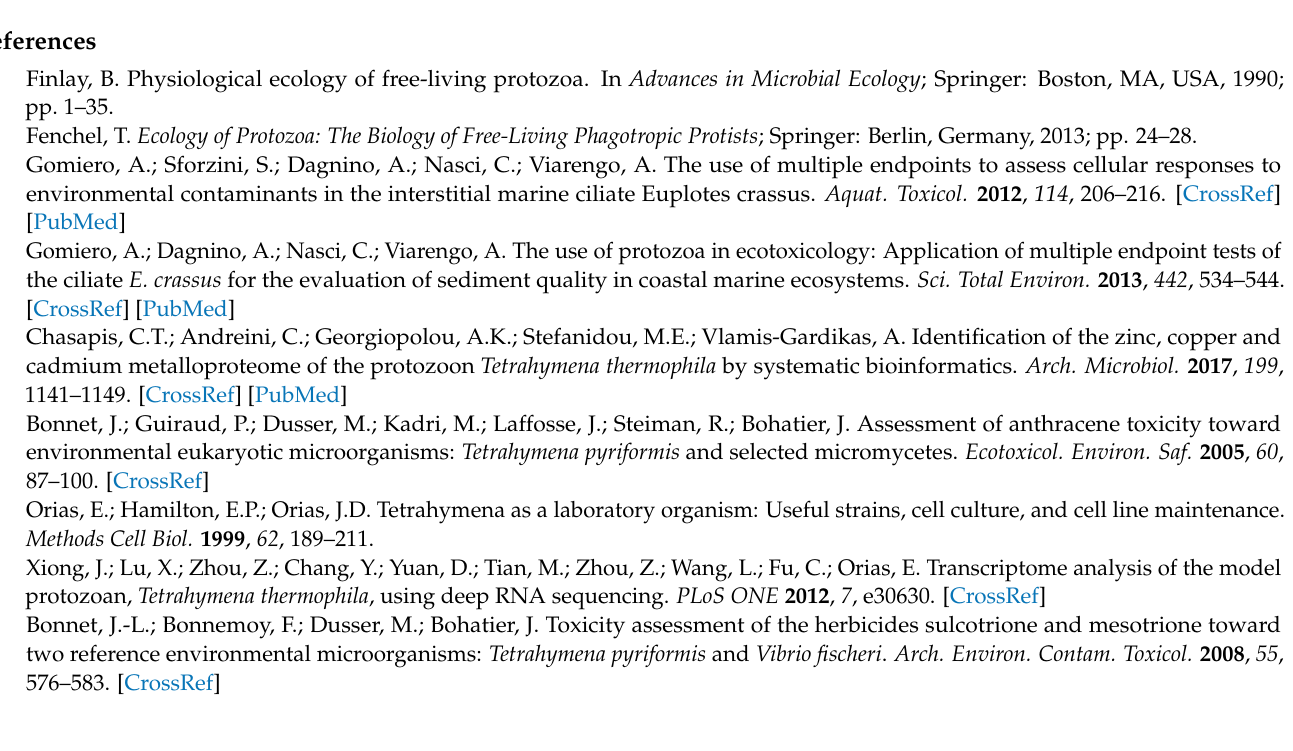
Figure A2. Swimming inhibition of Tetrahymena after 30 min exposed to copper sulfate. Using different concentrations (0, 0.5, 5, 50, 500, and 5000 µ M), the EC 50 was determined at 154.0 µ M which reduced swimming speed of cells to 50%. The data are expressed as mean ± standard deviation (SD). Video A1. Comparison of locomotor activity between DYH7neo3 mutant and CU428 wild-type Tetrahymena strains: https://www.youtube.com/watch?v=-Ehgu0MN9UQ. Video A2. Comparison of locomotor activity for Tetrahymena cultured in either rich or poor medium: https://www.youtube.com/watch?v=sk9wwTbrmgE. Video A3. Comparison of locomotor activity of Tetrahymena exposed to different doses of CuSO 4 :